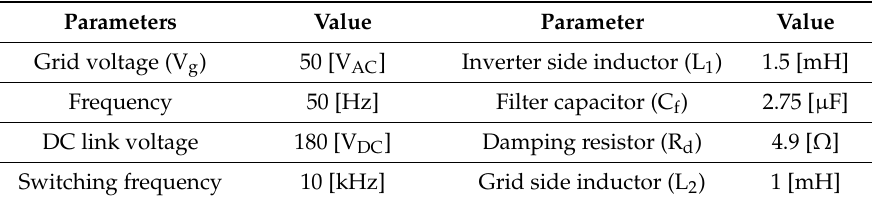
Table 2. GCI system and controller parameters.